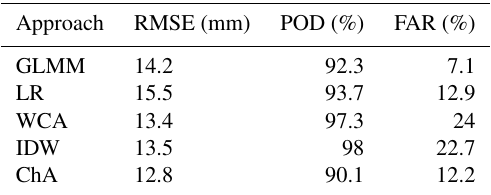
Table 5. Precipitation results in the leave-one-out cross validation for each interpolation